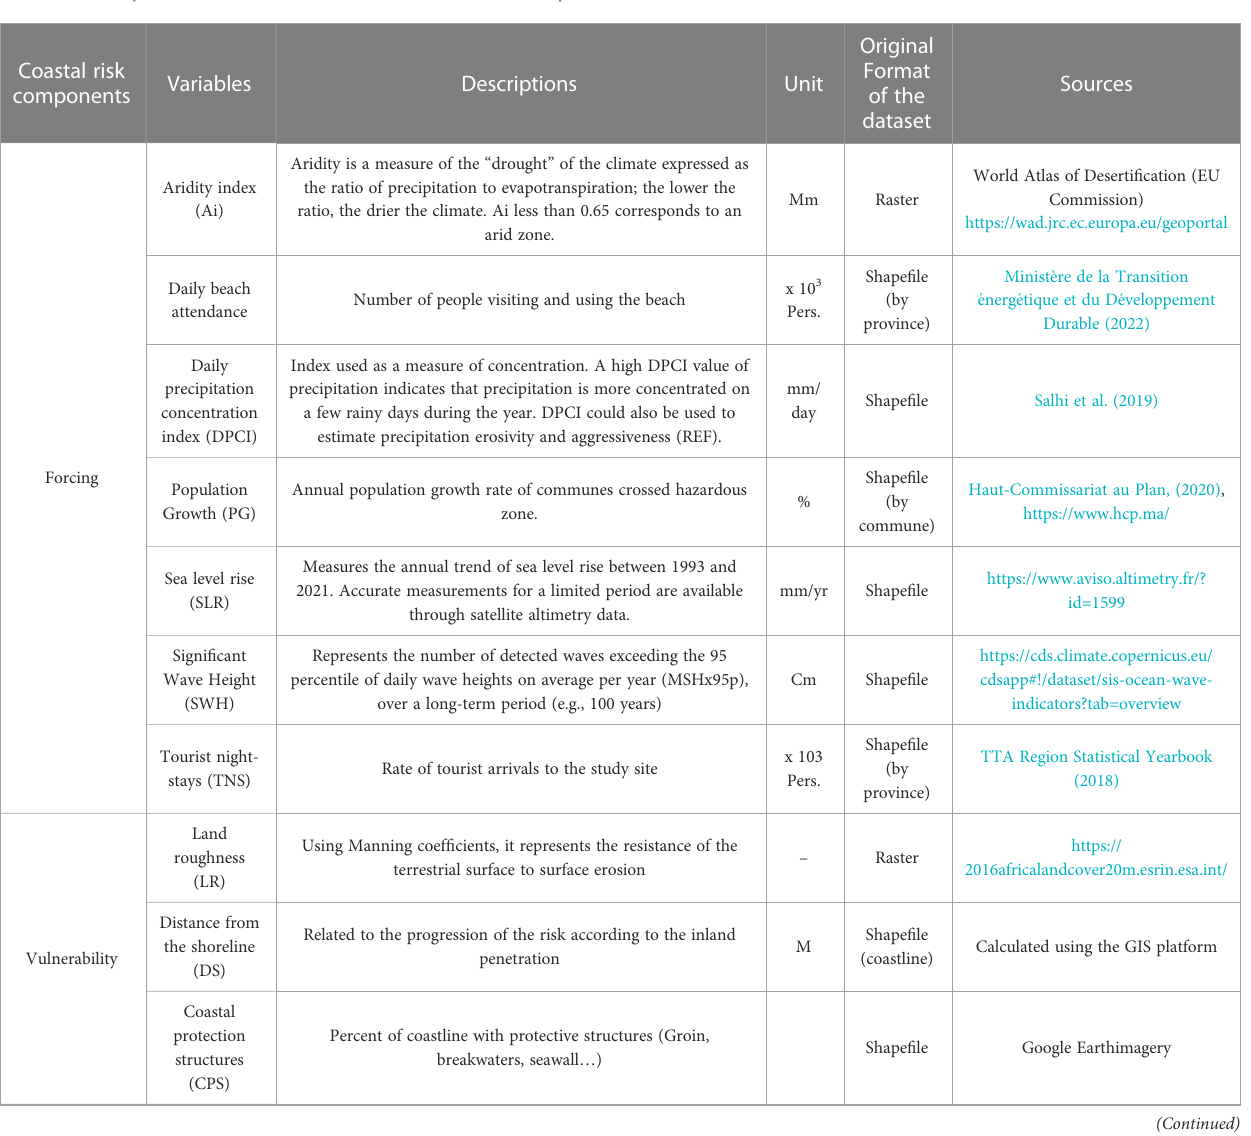
TABLE 2 Description of variables used to create the coastal risk map and their sources.